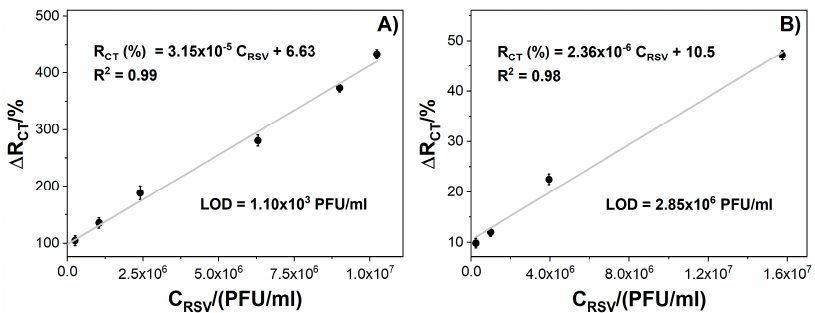
Figure 5. The relation between the immunosensor response expressed as R ct change ( Δ R ct ) and the virus protein concentration for: ( A ) Au/4-ATP/anti-RSV/BSA, ( B ) GC/PLL/anti-RSV/BSA. Registered in 5 mM K 3 [Fe(CN) 6 ]/K 4 [Fe(CN) 6 ]/0.01 M PBS. Error bars denote confidence interval ( α = 0.05, n = 3).